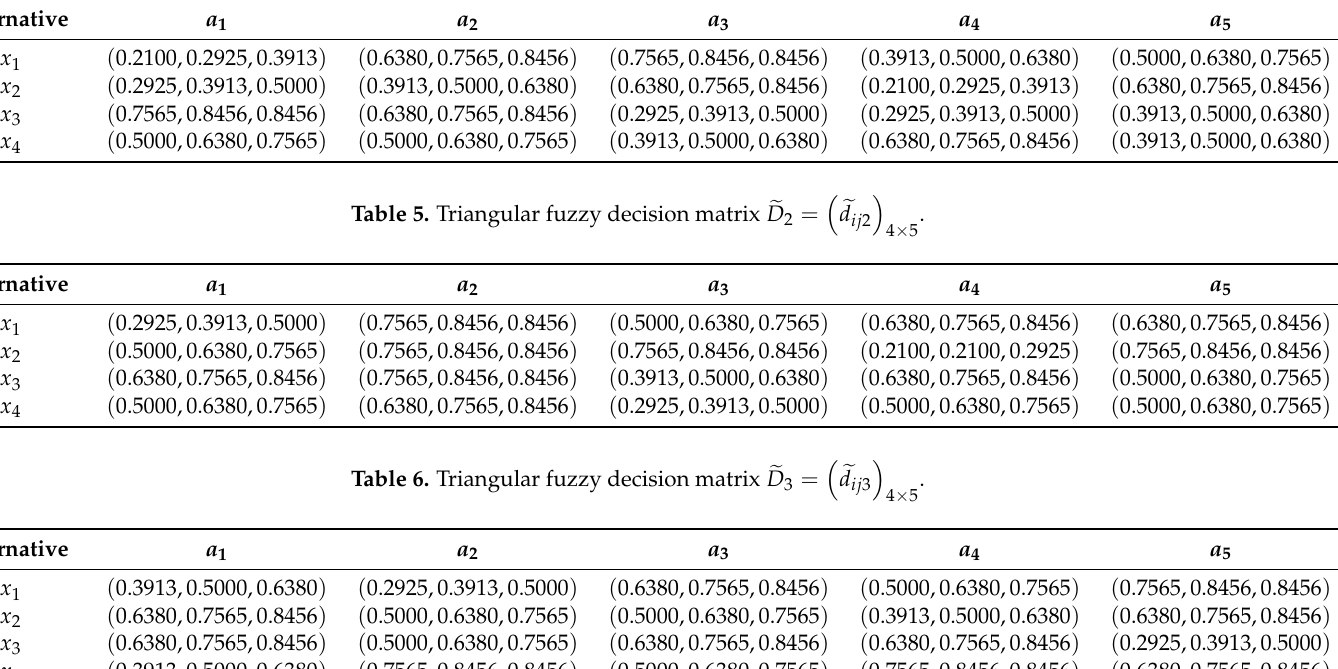
Table 4. Triangular fuzzy decision matrix (cid:101) D 1 =